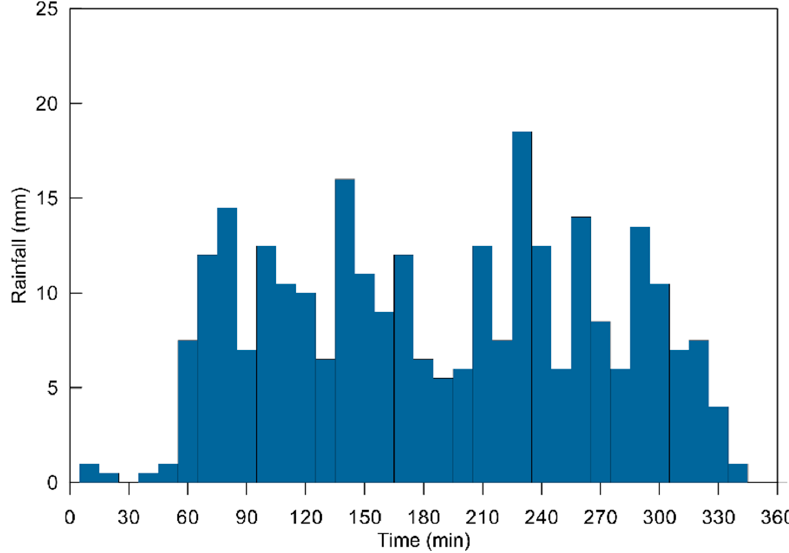
Figure 6. Rainfall data from 21 September 2010 for verification.